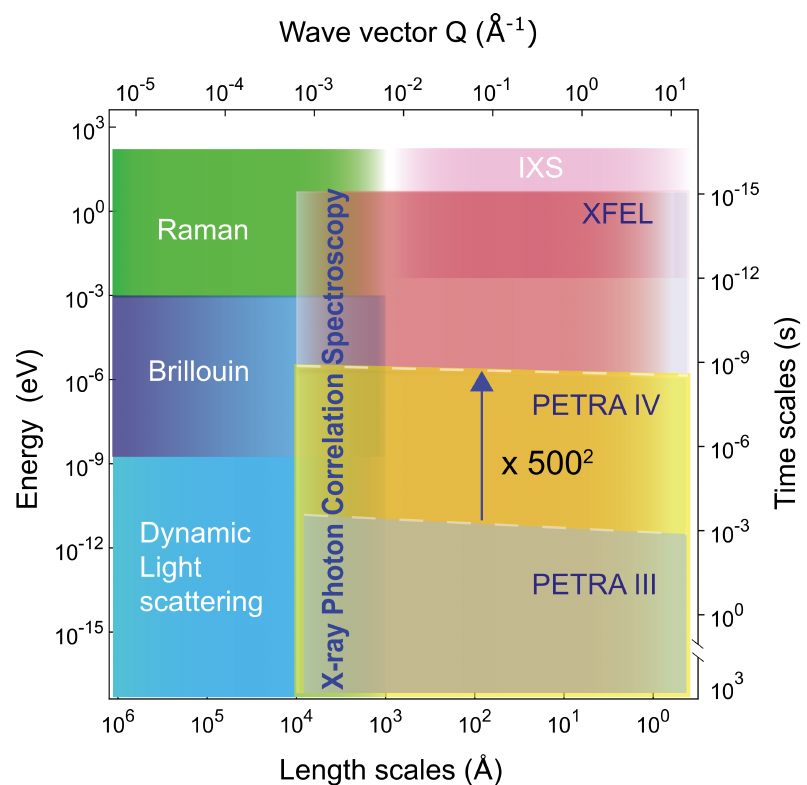
Figure 13. Length-time scale map of different scattering techniques. Raman, Brillouin and dynamic light scattering use optical lasers as source. IXS refers to inelastic X-ray scattering whose time resolution is given by the energy resolution. PETRA III and PETRA IV are exemplary used as storage ring sources. With PETRA IV, the brilliance is supposed to be increase by a factor of 500, leading to access of 500 2 faster time scales compared to PETRA III